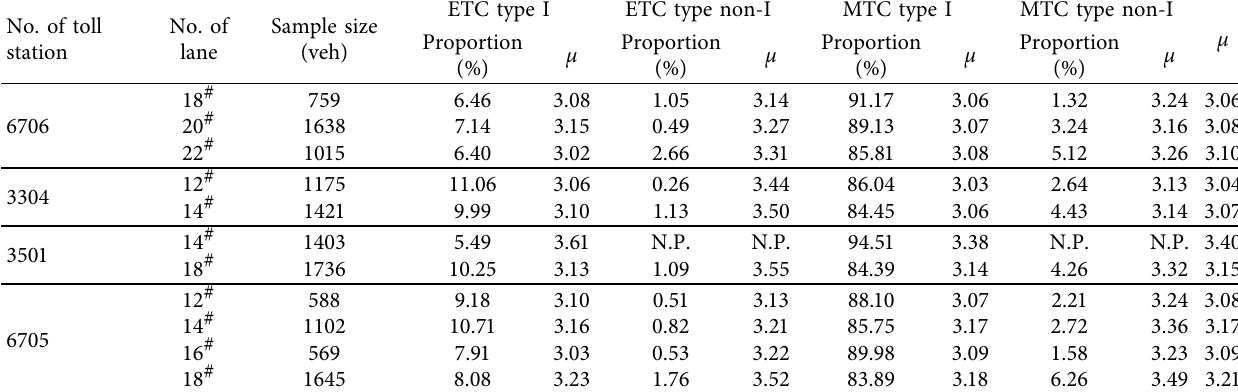
Table 6: Fitting parameters for the lognormal distribution of service time when ETC/MTC exits of toll stations are saturated. No. of toll